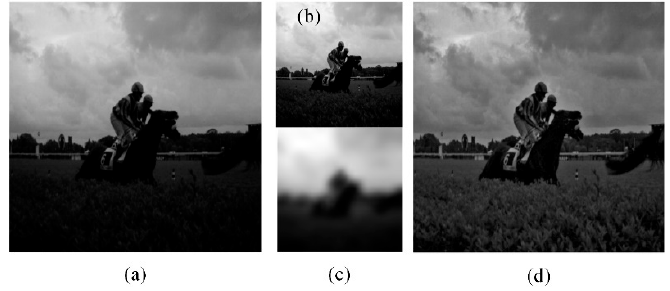
Figure 4. Result of the LSAGC method. ( a ) Original image. ( b ) LL . ( c ) SLDF ( x , y ) of LL . ( d ) Recon- structed image after applying LSAGC.